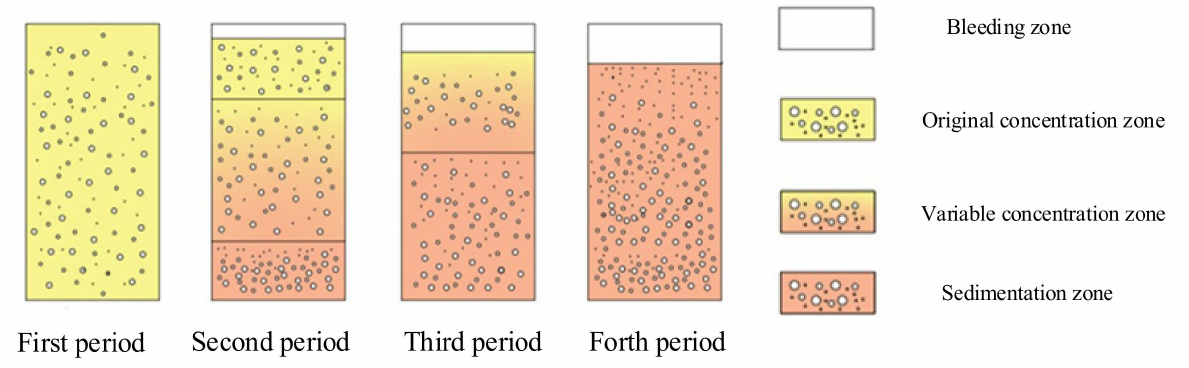
Figure 13. Schematic diagram of bleeding settlement